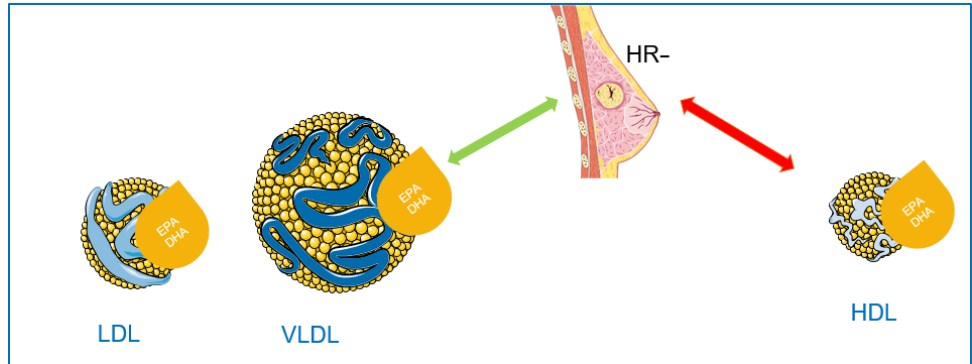
Figure 2. Schematic hypothesis of dual effects of EPA and DHA on HR− breast cancer tumor according to the lipoprotein carriers, green arrow suggesting protective effect compared to red arrow suggesting a pejorative effect. LDL: low-density lipoprotein; VLDL: very low density lipoprotein.